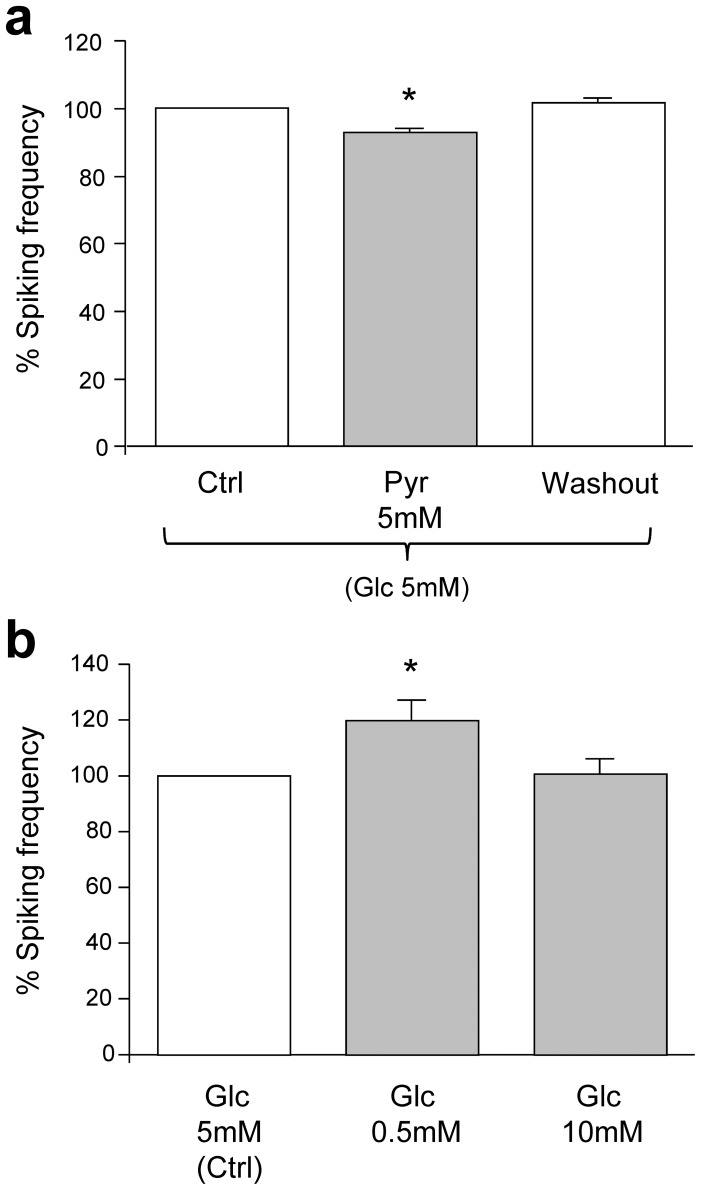
Energy metabolite dependency of calcium spiking frequency.Calcium spikes frequency shown as percent of activity measured during control solution. (a) Effects of pyruvate on calcium spiking frequency (n = 188 cells, 24 exp). Glucose (5 mM) was present throughout the experiments. (b) Effects of glucose concentration on spiking frequency (n = 68 cells, 10 exp).